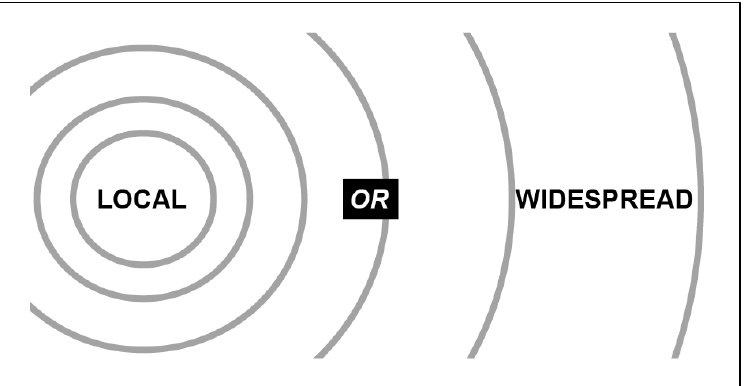
Figure 2. Mode of Impact—Distribution. Distribution is the first mode of impact concerning the negative externalities of urban development. Local distribution (on the left) radiates outward to- ward widespread distribution (on the right). The concentric circles show the distribution radiating outward from the source, indicating how an impact is felt. An example of a negative externality that is felt locally is increased traffic noise pollution, whereas an example of a negative externality that is felt over a widespread area is decreased housing affordability. Following distribution, the next mode of impact is visibility (Figure 3). Visibility ex- plores the ease with which a negative externality can be observed and measured. For ex- ample, a negative externality with high visibility is increased slum development ; an exam- ple of a negative externality with low visibility is decreased groundwater table and quality. While both have consequences, a more visible impact may receive more attention.